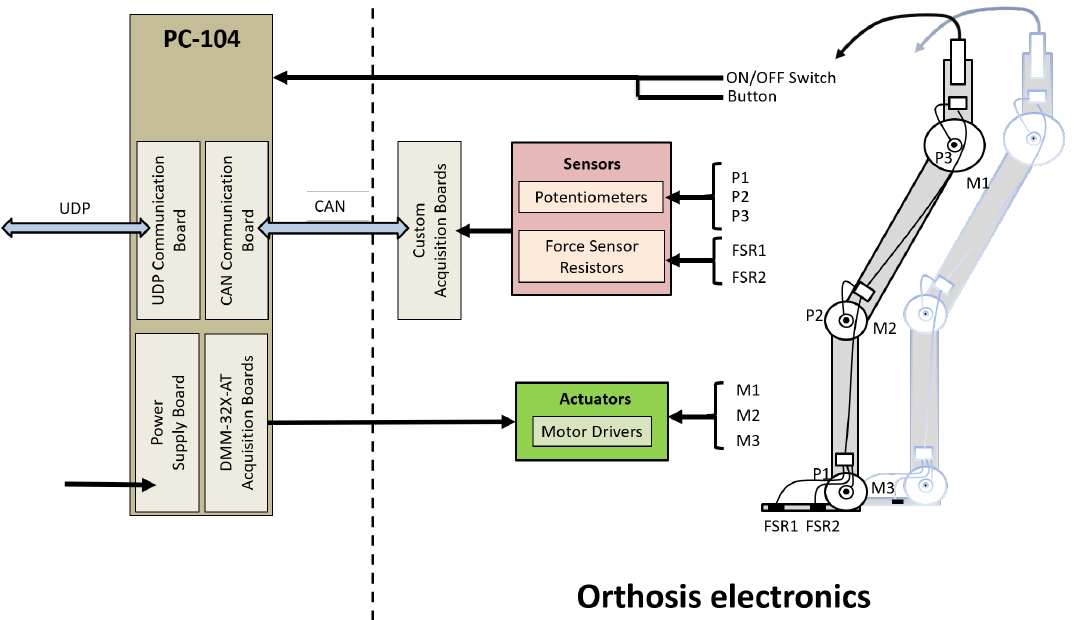
Figure 5. H1 exoskeleton electronics architecture. UDP: User Datagram